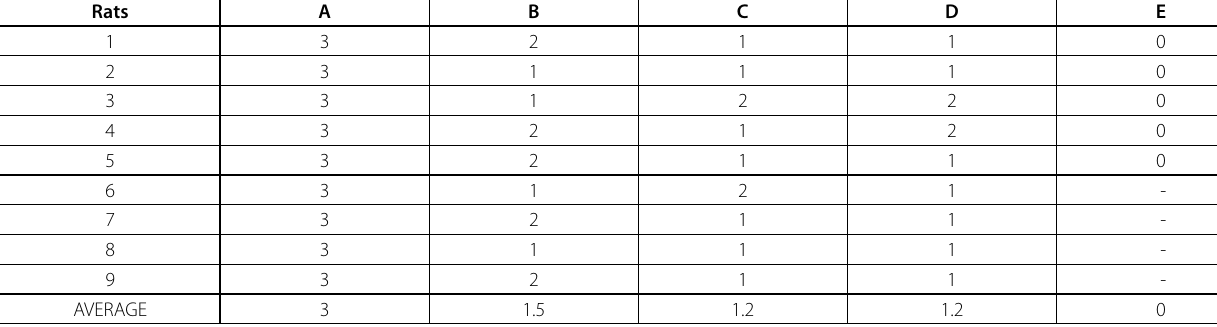
P =0.0029 (Kruskal-Wallis) Histopathological classification of liver parenchyma injury in rats